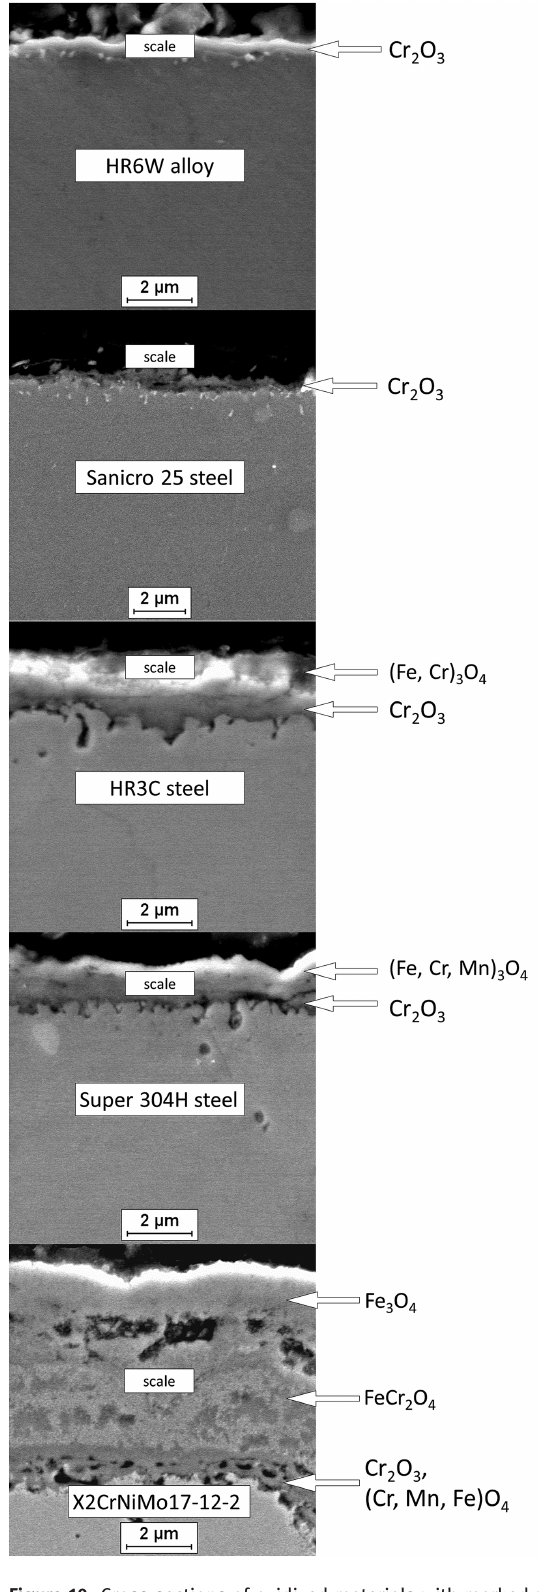
Figure 10: Cross-sections of oxidized materials with marked phases constituting growing scales.